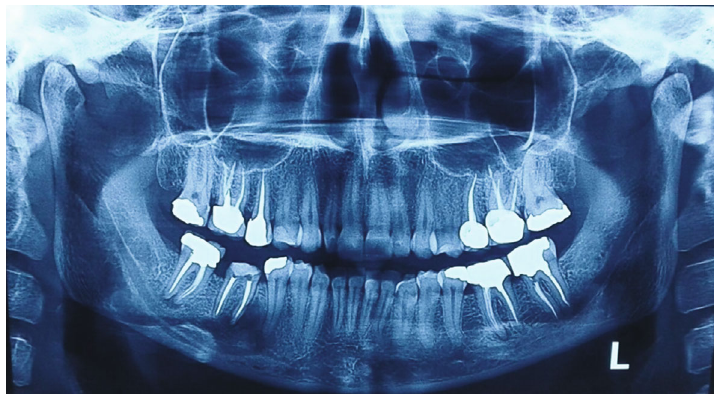
Figure 5: Mandibular second molar was endodontically retreated and referred back to us for further